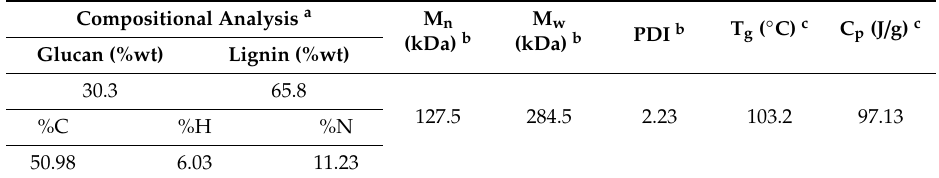
Table 1. Characteristics of Butyrated Biorefinery Lignin